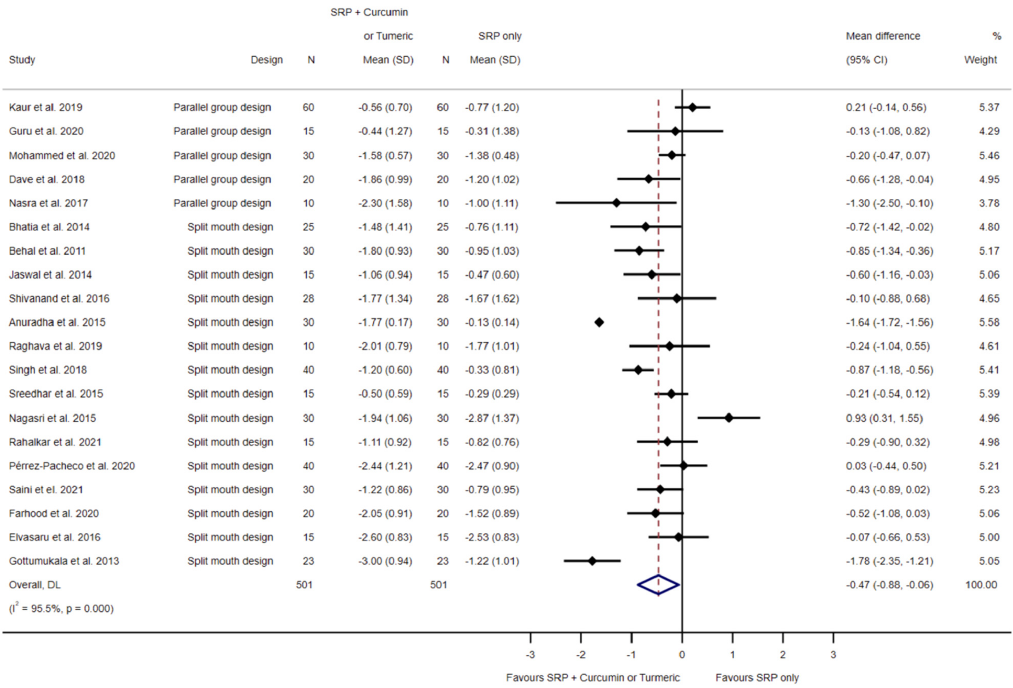
Figure 5. Forest plot for the comparison of SRP to SRP and local curcumin/turmeric application related to probing pocket depth reduction [31–46,50–53].